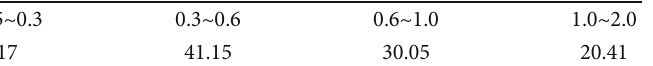
Table 1: The particle size distribution of soil.